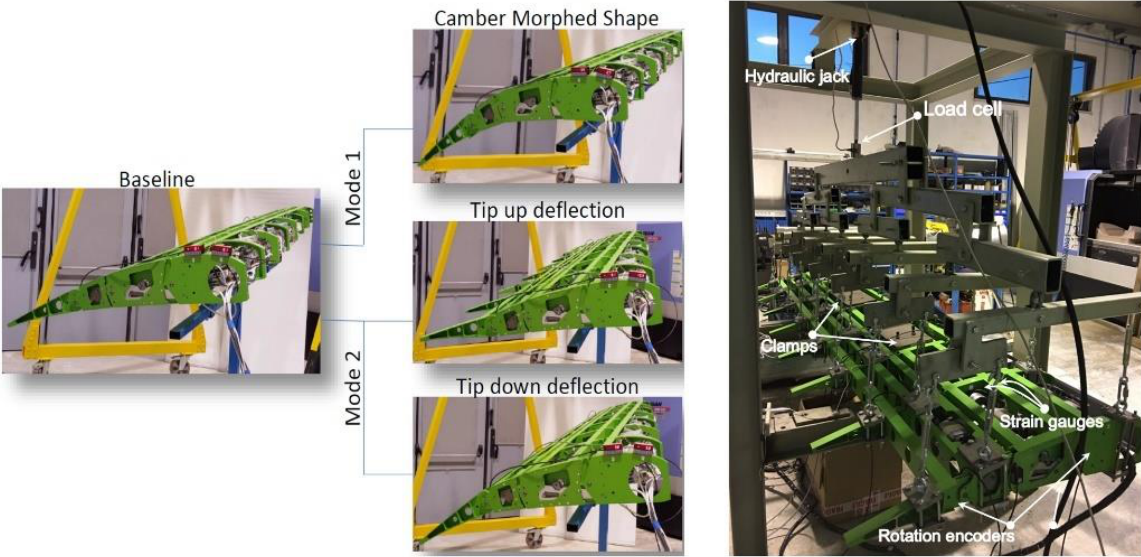
Figure 4. Morphing flap, full-scale functionality test ( left ), and static test ( right ).